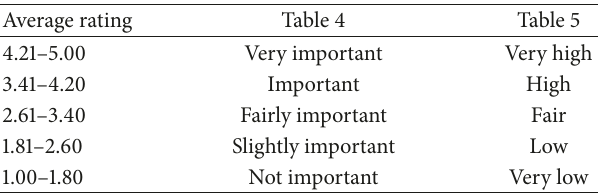
Table 3: Interpretation of the semiquantitative results from Tables 4 and